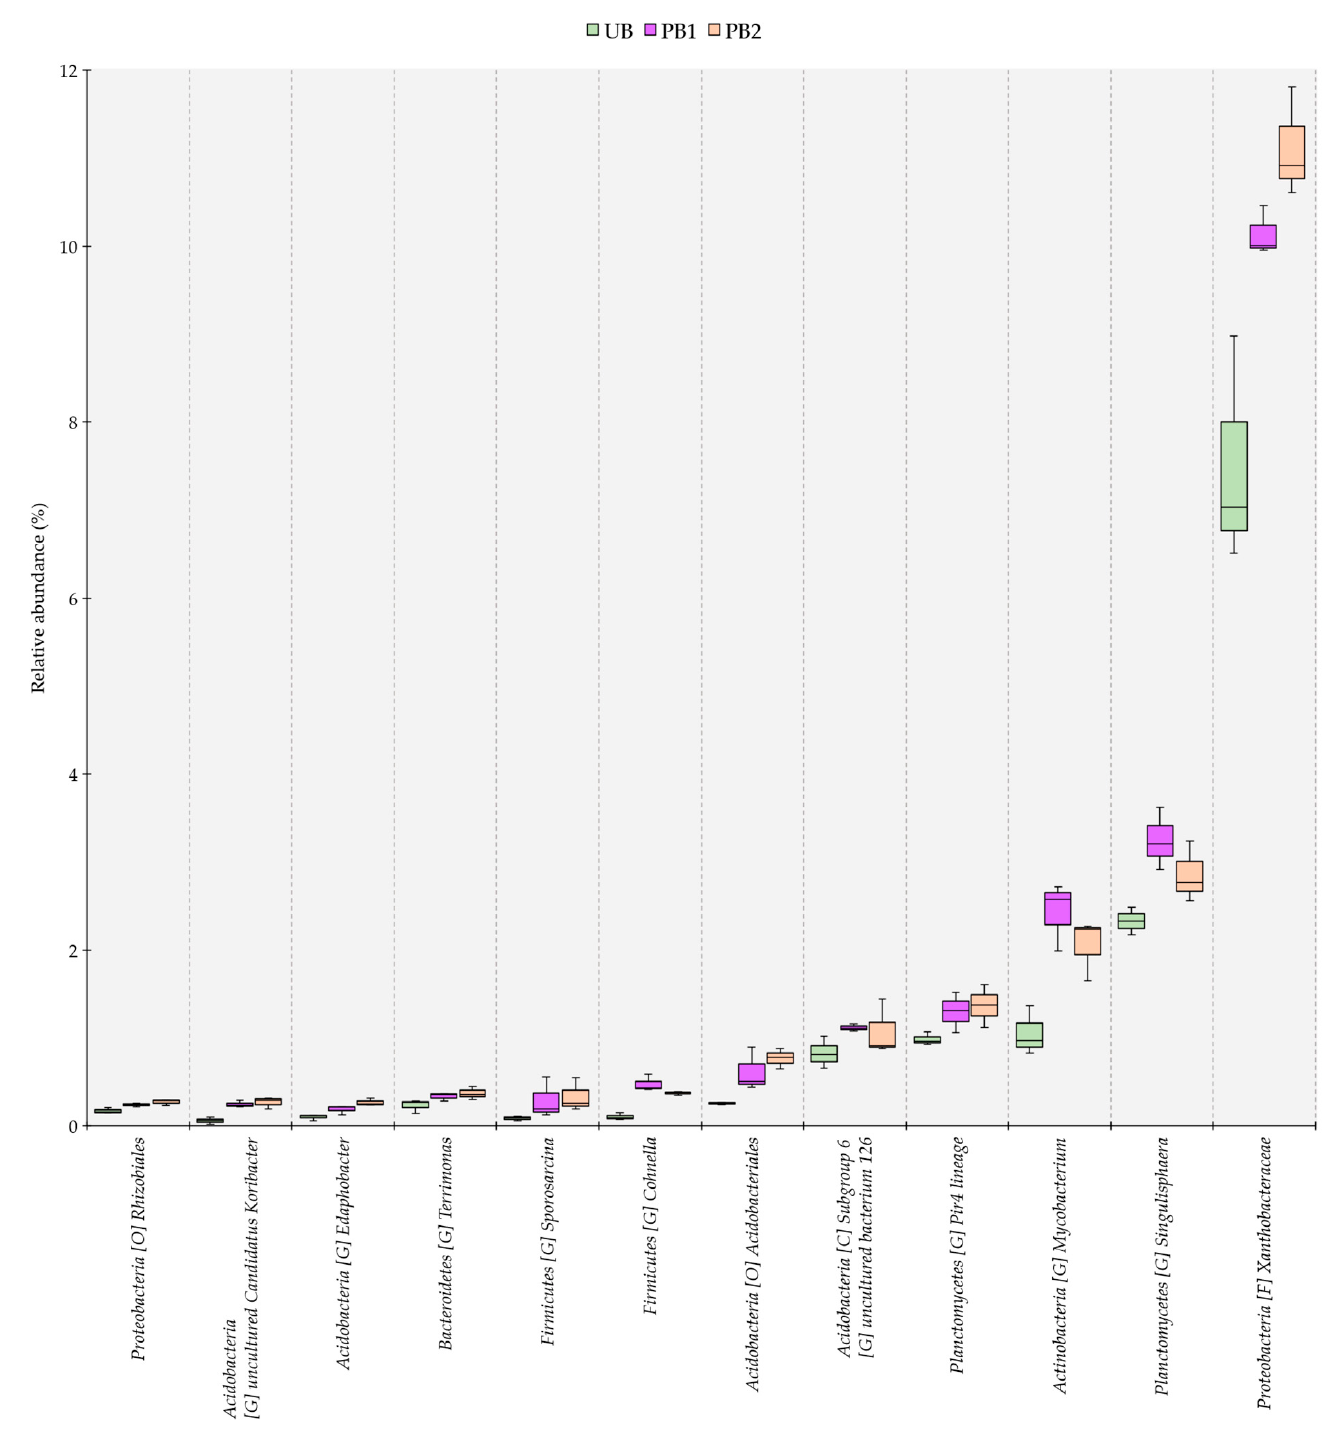
Figure 7. Bacterial taxa increasing in relative abundance (%) after application of prescribed burning regardless of the time elapsed since treatment. UB: control; PB1: soils treated with prescribed burning seven months before sample collection; PB2: soils treated with prescribed burning immediately prior to sample collection. Boxes include 50% of the data between the first and third quartiles (interquartile range) and the central line, the median. The whiskers include those values that deviate from the first and third quartiles up to a maximum distance of 1.5 times the interquartile range. Capital letters in square brackets indicate the lowest taxonomic level of classification: [O]: order, [C]: class, [F]: family, [G] genus.